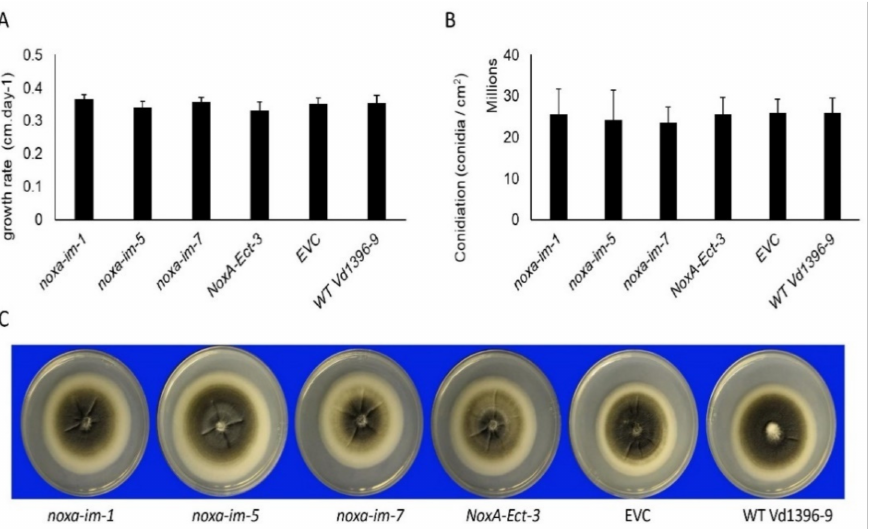
Figure 3. Phenotypic analysis of noxa mutants on PDA medium. ( A ) The growth rate of noxa mutants. ( B ) The conidiation of noxa mutants. ( C ) The colony phenotype of noxa mutants. The bars shown as mean values ( n = 8) for growth rate experiment and ( n = 5) for conidiation experiment. No differences were observed between different isolates ( p < 0.05). Error bars refer to standard